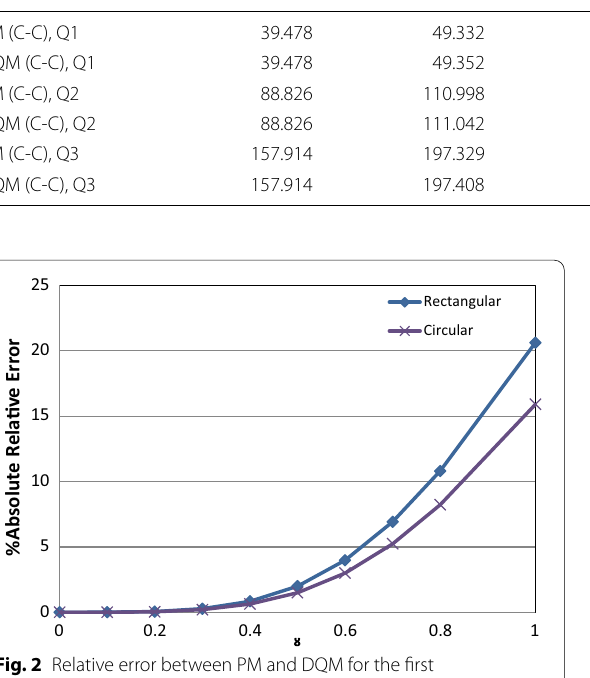
Table 6 Results of DQM and PM for the non-dimensional buckling parameter of clamped–clamped non-prismatic circular beam Non-dimensional buckling parameter